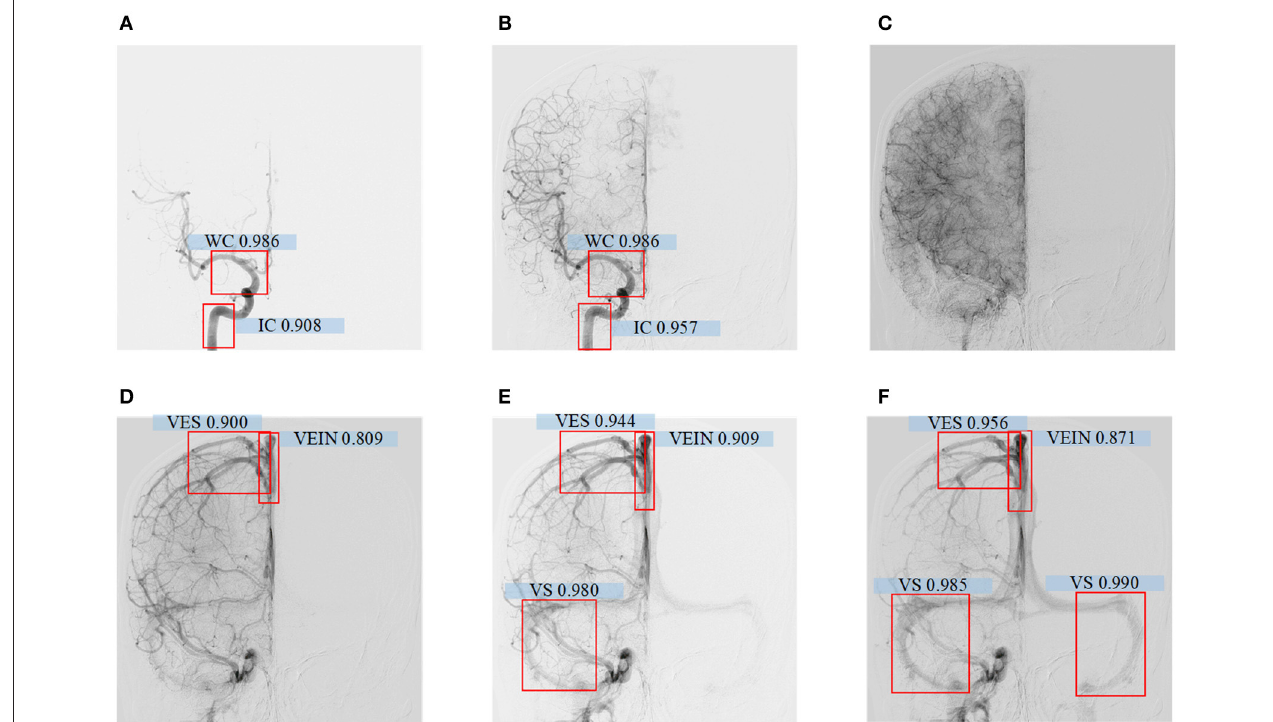
FIGURE 5 | (A–F) Detecting results of DSA videos with different phase. From left to right are arterial phase I, II, capillary phase, vein phase, venous sinus phase I, and venous sinus phase II. In arterial phase I, the confidence level of the internal carotid artery is 0.908, the Willis Circle is 0.986; In arterial phase II, the internal carotid artery is 0.957, the Wil lis Circle is 0.986; In vein phase, the confidence level of vein detection is 0.809, venous vessel is 0.900; In venous sinus phase I, the confidence level of vein is 0.909, venous vessel is 0.944, venous sinus is 0.980; In venous sinus phase II, the confid ence level of large vein is 0.871, venous vessel detection is 0.956, and venous sinus is 0.985 and